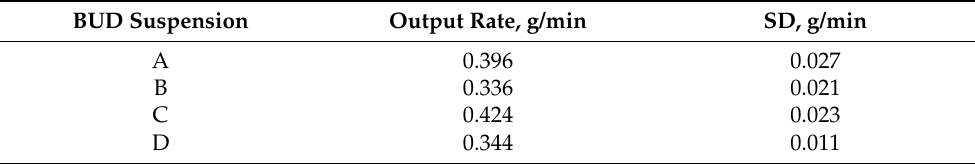
Table 5. The average mass output (aerosol emission) rate of BUD suspensions in the VMN. SD denotes the standard deviation ( n =